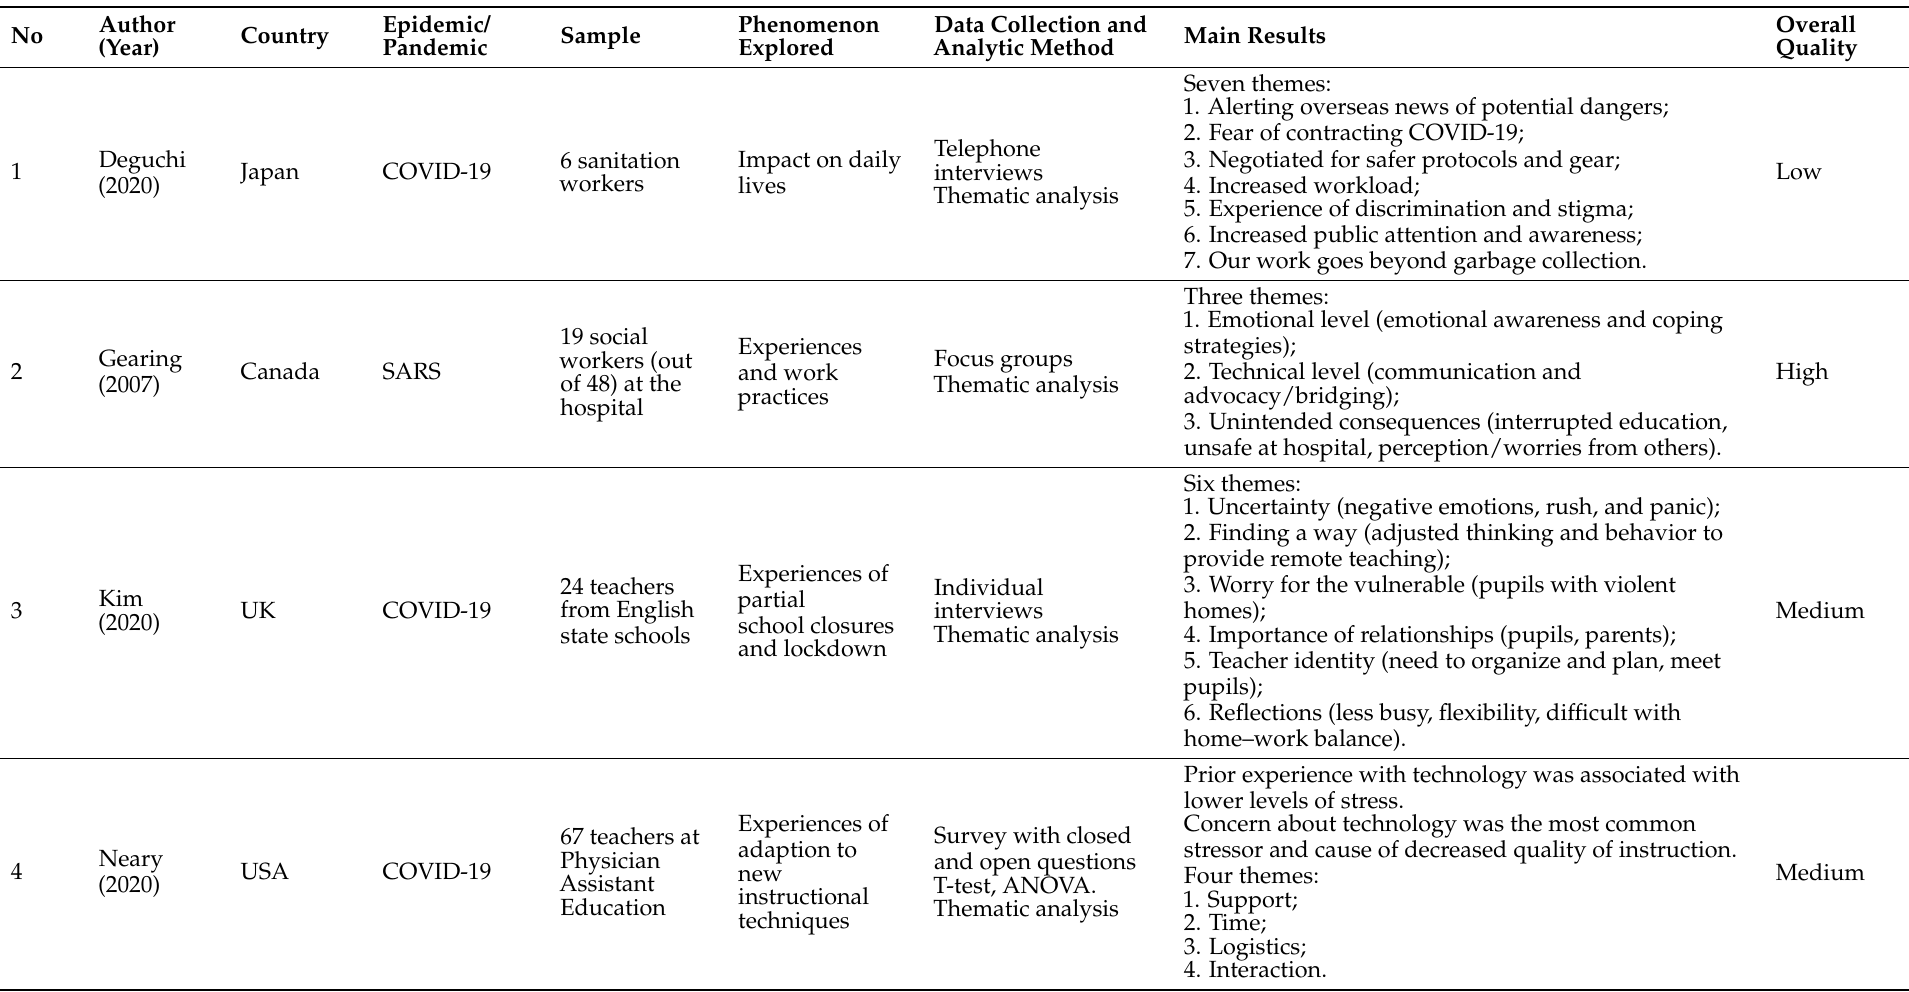
Table 7. Overview of qualitative and mixed-methods studies exploring how the work environment outside the healthcare sector is affected by an epidemic or pandemic (research question 1) and studies investigating the associations between the work environment and health during an epidemic or pandemic (research question